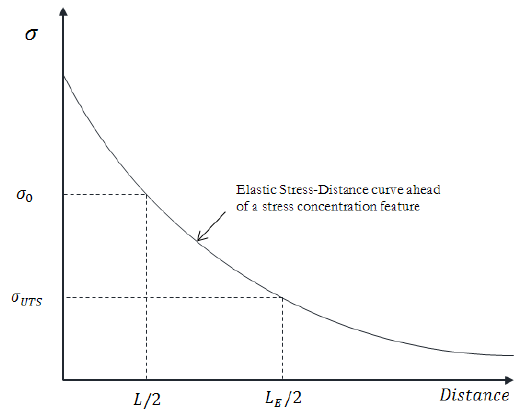
Figure 2: Failure stress and critical distance